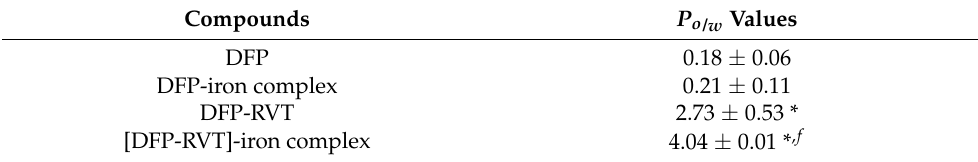
Table 1. Partition coefficient ( P o / w ) values obtained from three repetitions are expressed as mean ± SD values. * p < 0.05 when compared with DFP; p < 0.05 when compared with the free ligands.